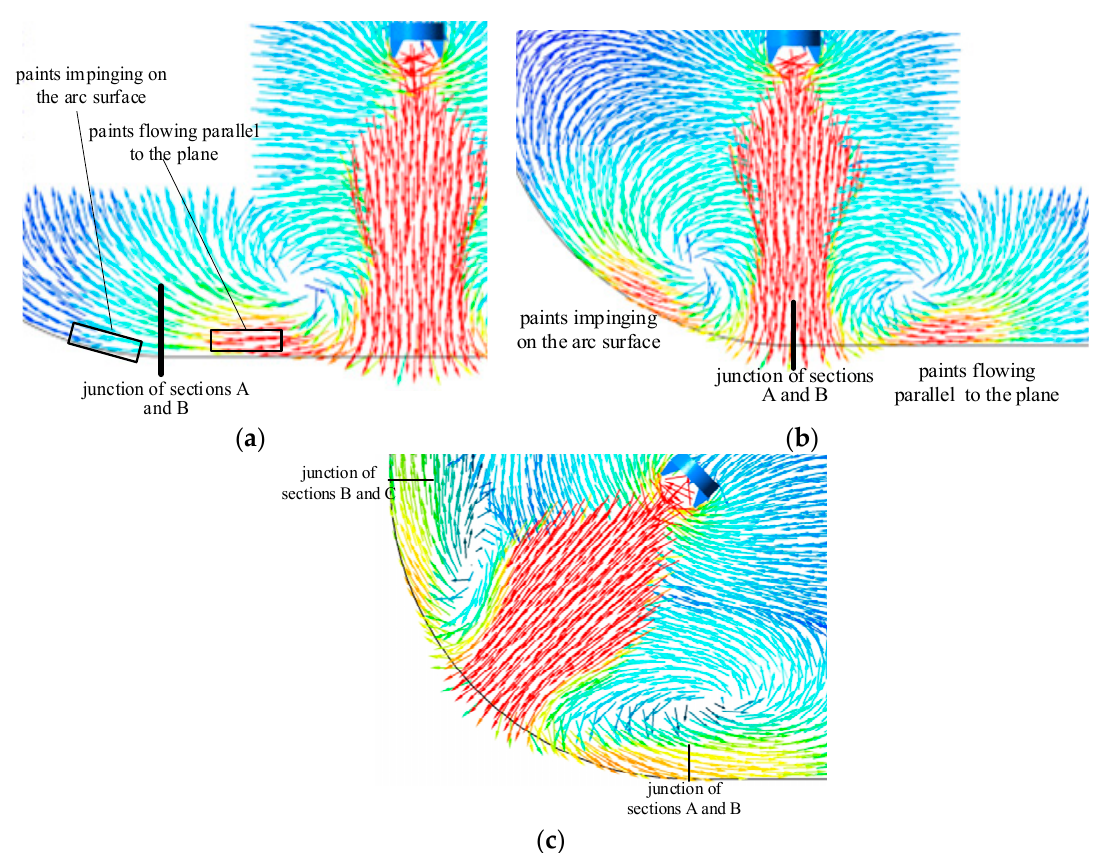
Figure 8. Velocity vectors of the paint phase during painting process for 90-degree arc connecting surface. ( a ) section A; ( b ) junction of sections A and B; ( c ) section B.